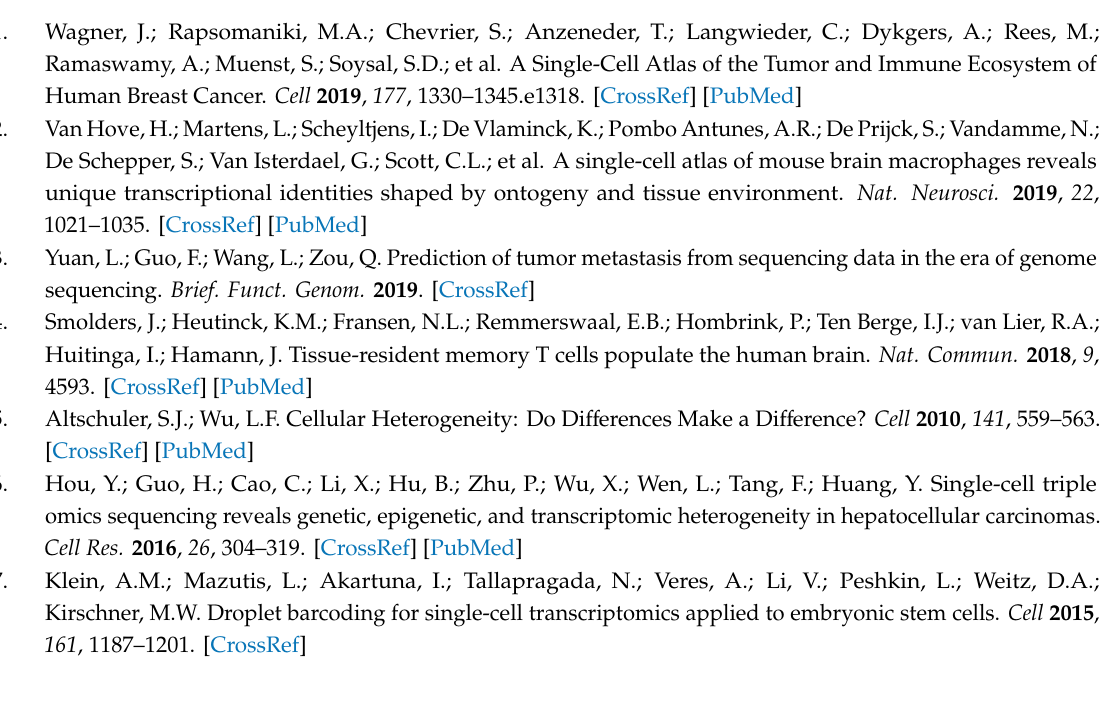
Figure S3: Simulation results with 2 cell types; Supplementary Figure S4: Simulation results with 5 cell